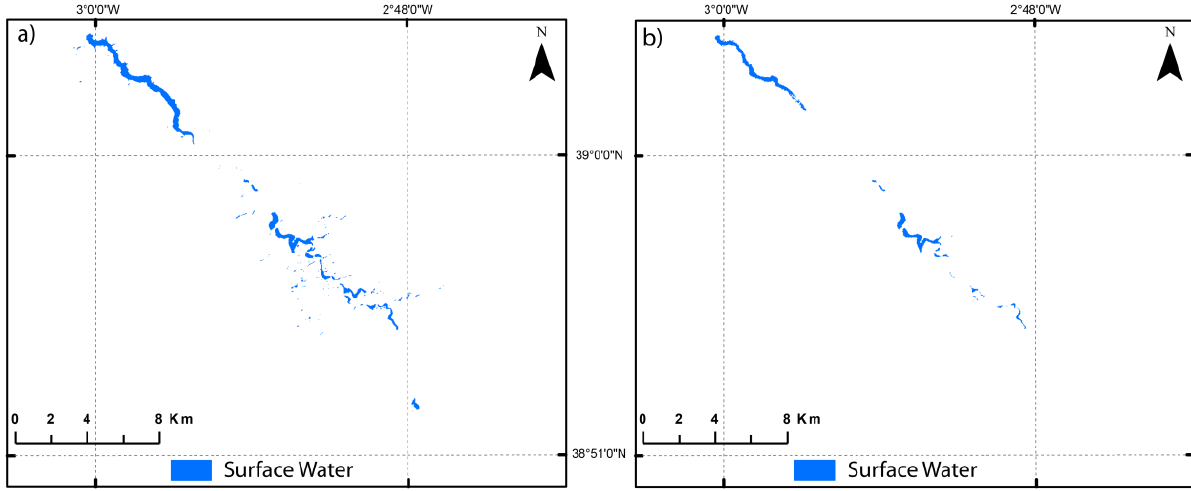
Figure 4. Spatial distribution of the surface water within the period 1984 to 2015: ( a ) maximum surface water; ( b ) minimum surface water.